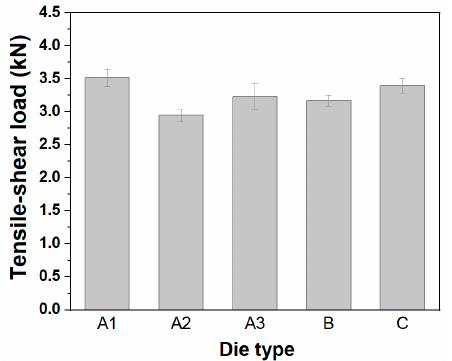
Figure 12. Tensile–shear loads for SPR joint of Al5052-H32 (top) and vibration-damping steel (bottom) with respect to SPR die type.